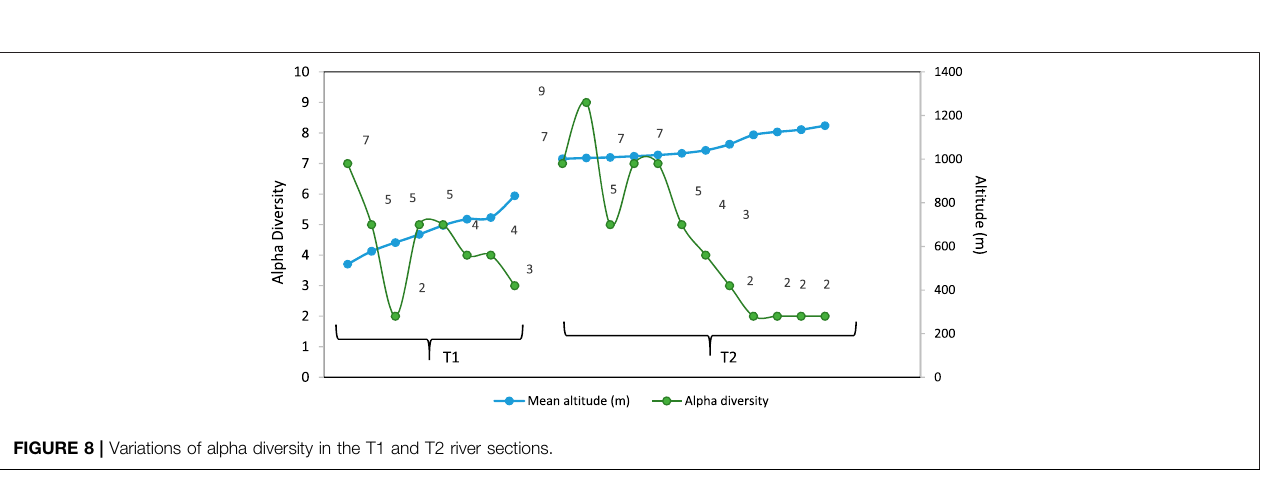
FIGURE 7 | Canonical Correspondence Analysis (CCA): relationship of fi sh species and environmental variables for T1 (A) and T2 (B) river sections (used as exploratory method).